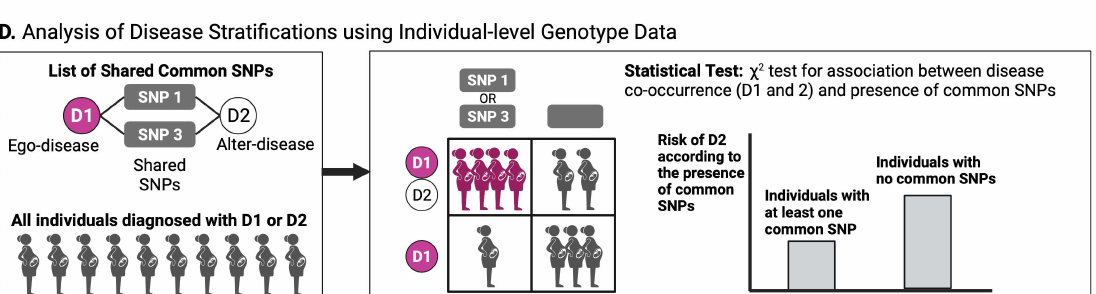
Figure 1. An overview of our pipeline for identifying potential disease complications of obstetric disorders. Using data from PheWAS we can generate a corresponding DDN, where nodes represent diseases and edges represent common associated SNPs between diseases. For each obstetric phenotype of interest, we take a subset of the overarching DDN to generate a corresponding egocentric network, where the central ego-node represents the phenotype in question. All other diseases that share at least one SNP in common with the ego-node are included as alter-nodes in this network. Finally, label propagation through GSSL can be applied to calculate association scores for the alter-nodes, giving us an indication of how related phenotypes are to one another. Individual-level genotype data can be explored to identify how genetic variants for patients might stratify them for comorbidity risk. PheWAS, phenome-wide association study; SNP, single nucleotide polymorphism; DDN, disease–disease network; GSSL, graph-based semi-supervised